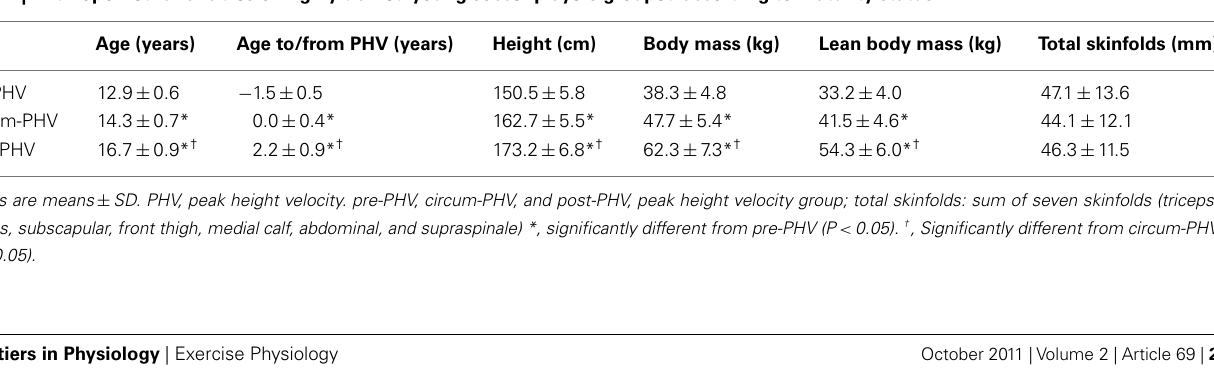
Table 1 |Anthropometric variables of highly trained young soccer players grouped according to maturity